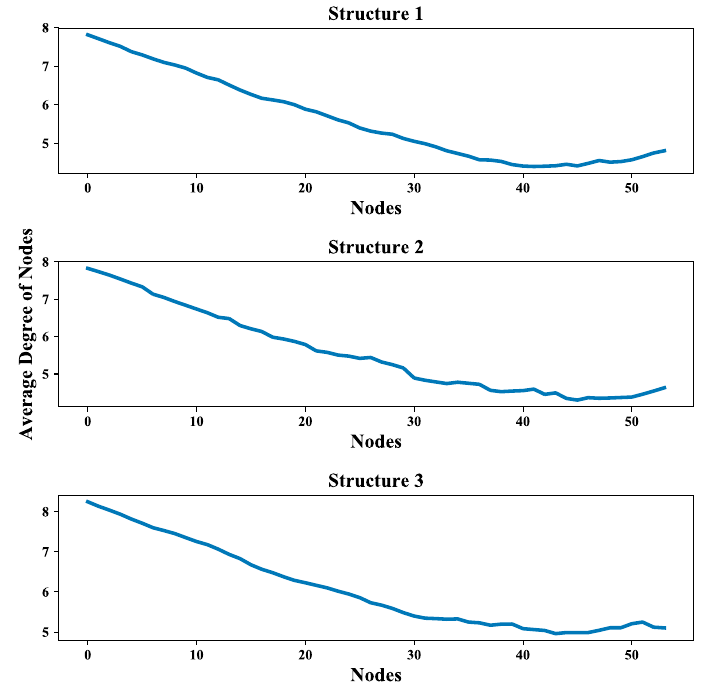
Figure 25. Effect of node removing on values of average degree of nodes.